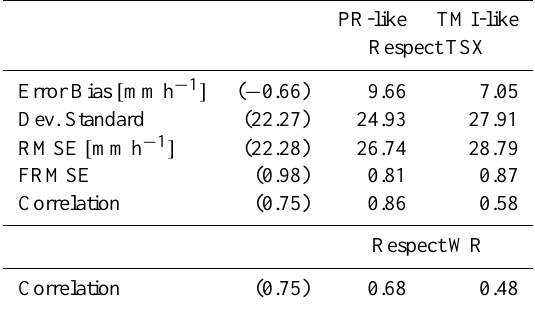
Table 2. Error analysis of the difference between the rain fields obtained at the spatial resolution of PR-like (4km) and TMI-like (15km) respect rain fields obtained at full resolution by TSX es- timations and WR measurements. In brackets values of the WR – TSX rain rate difference. Error bias is respect TSX – de- graded simulation